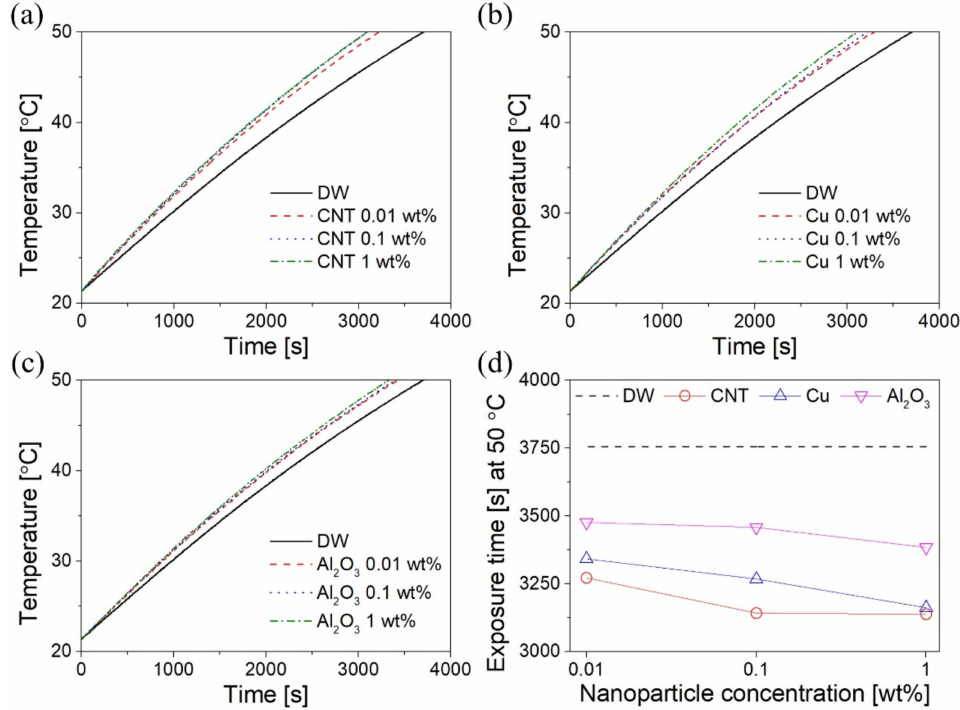
Figure 7. Temperature profiles of nanofluids with three different nanoparticle concentrations (where “DW” indicates 100% distilled water). ( a ) CNTs, ( b ) Cu, ( c ) Al 2 O 3 , and ( d ) exposure time at 50 ◦ C. Table 2. Effect of varying nanoparticle concentration on the exposure time (s) at 50 ◦ C. Type 0.01